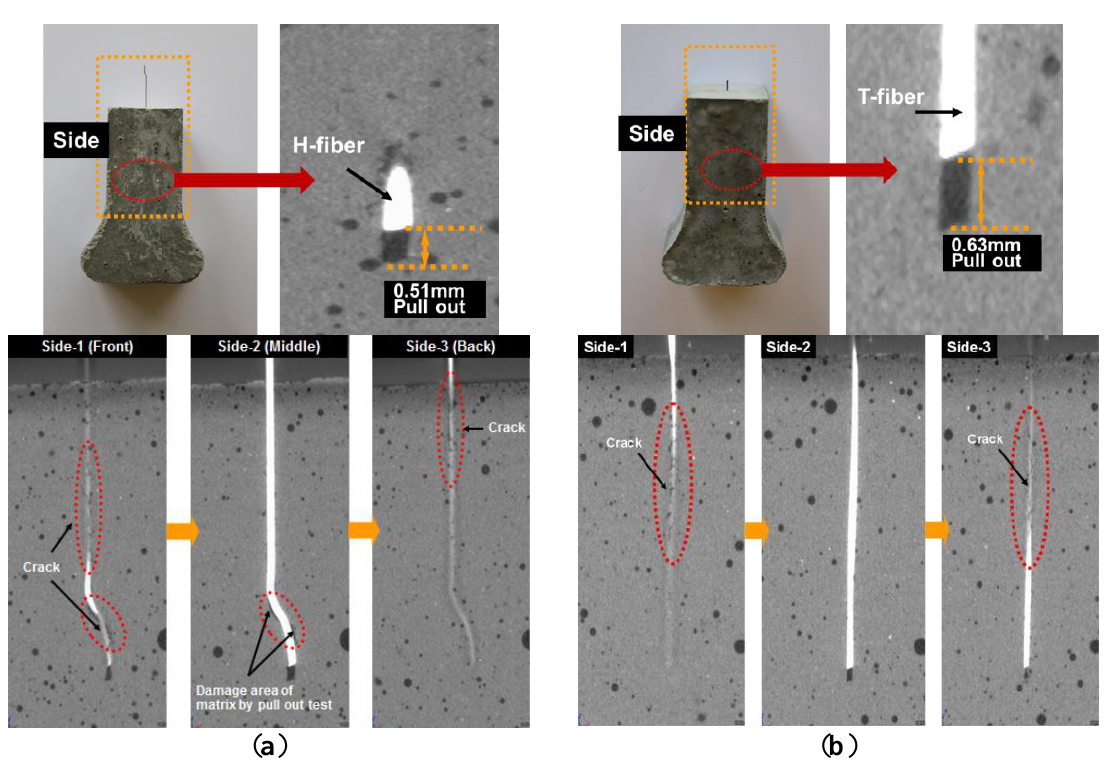
Figure 7. Interfacial cracking behavior of fibers after fiber pullout. ( a ) Hooked fiber; ( b ) Twisted